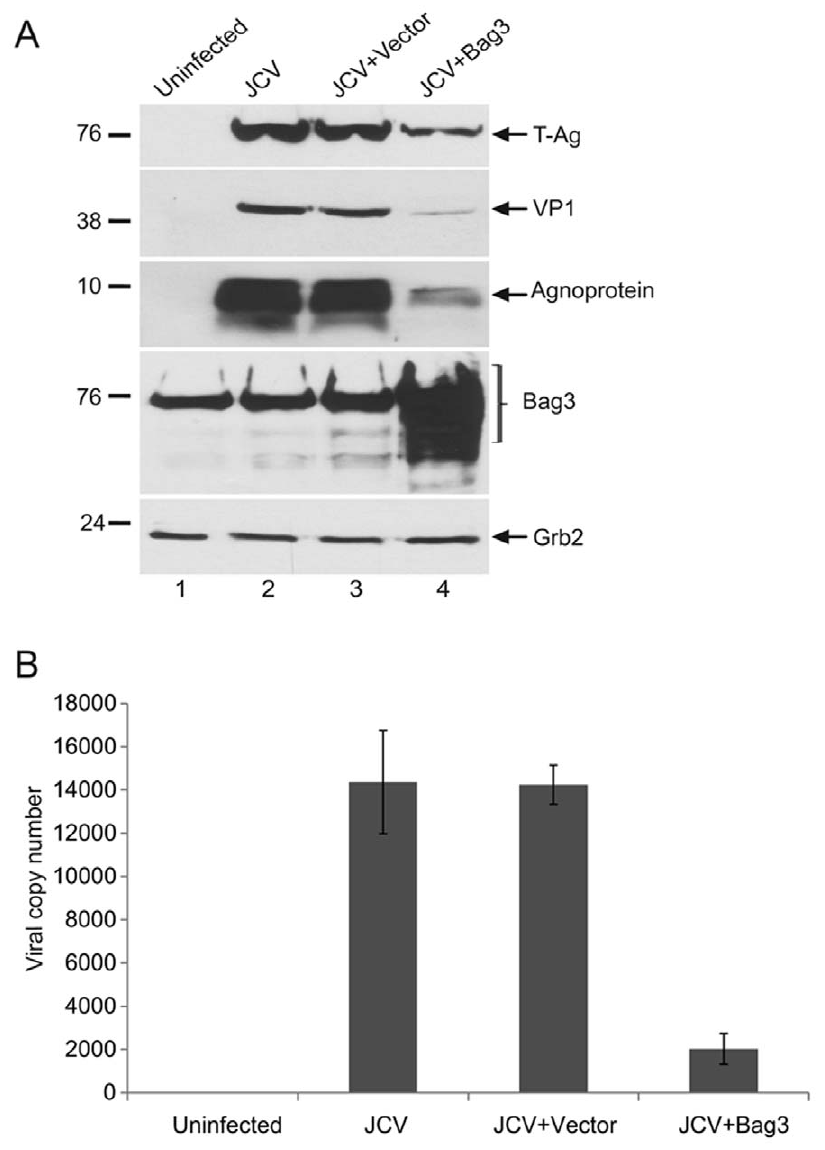
Figure 2. Bag3 inhibits replication of JCV in primary culture of human fetal glial cells. A. Western blot analyses of whole cell protein extracts prepared from JCV infected cells using specific antibodies against T-Ag, VP1, Agnoprotein, Bag3, and the housekeeping protein, Grb2. In lane 1, extracts from uninfected cells were loaded as a control. B. Q-PCR analyses of the viral particles in the JCV infected-cells culture medium as described in the Materials and